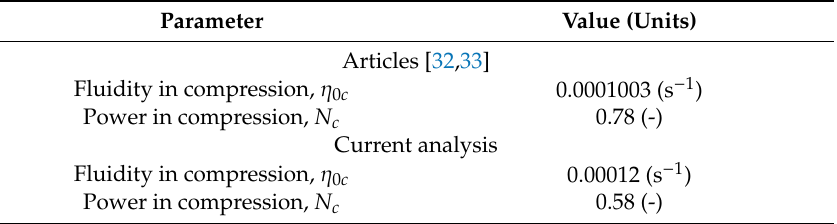
Figure 10. Comparison of the CEB recommendations with the strain rate sensitivity predicted for concrete by the continuous damage surface cap model. Table 4. Main parameters used to predict the dynamic properties of